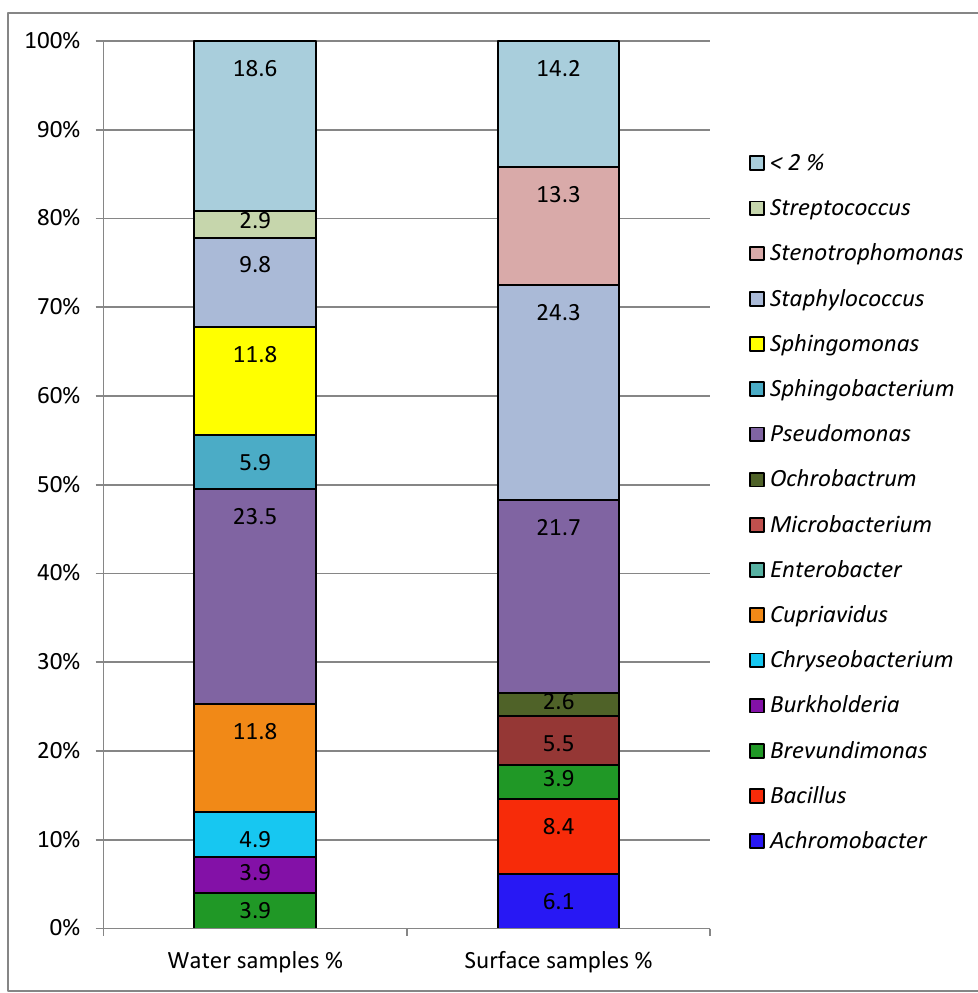
Figure 3. Taxonomic profile up to genus level for all antibiotic-resistant isolates. Left column: percentage of water isolates ( n = 102); right column: percentage of isolates from surfaces ( n = 307). Other genera present in <2%. Identification to the species or genus level was performed using BD Phoenix™ and MALDI-TOF-MS.